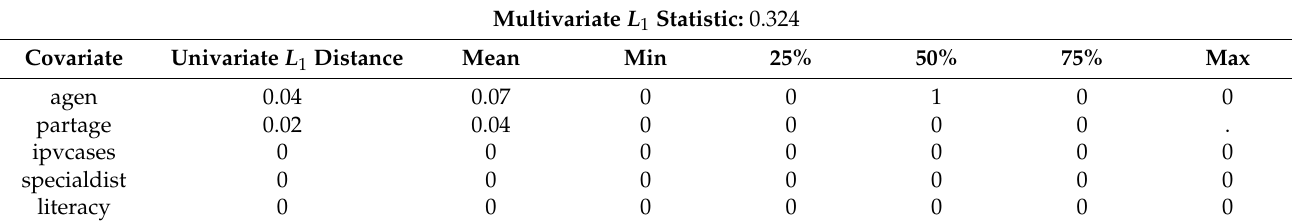
Table 5. K-to-K matching